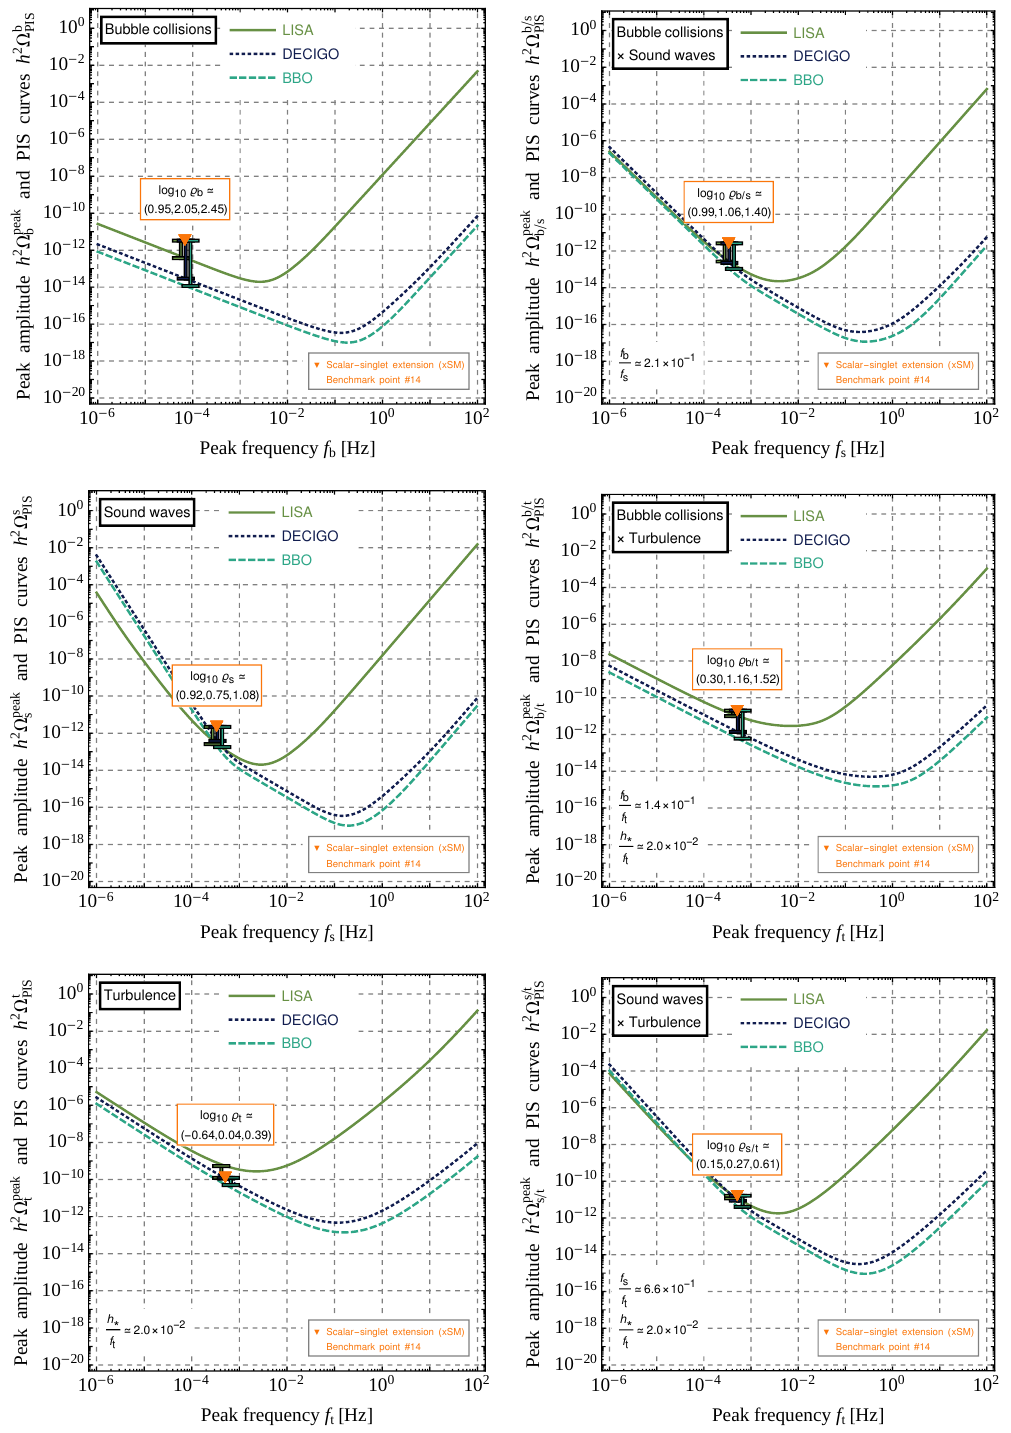
Figure 2 . PISCs for LISA, DECIGO, and BBO together with the predictions of BP #14. See